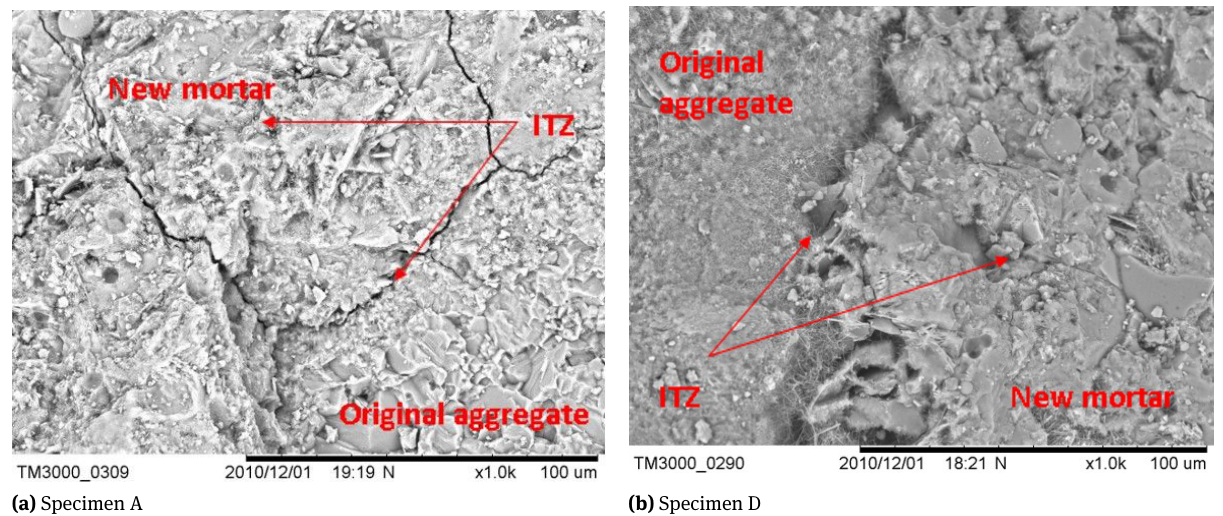
Figure 11: SEM images of ITZ between original aggregate and new mortar in specimen A and